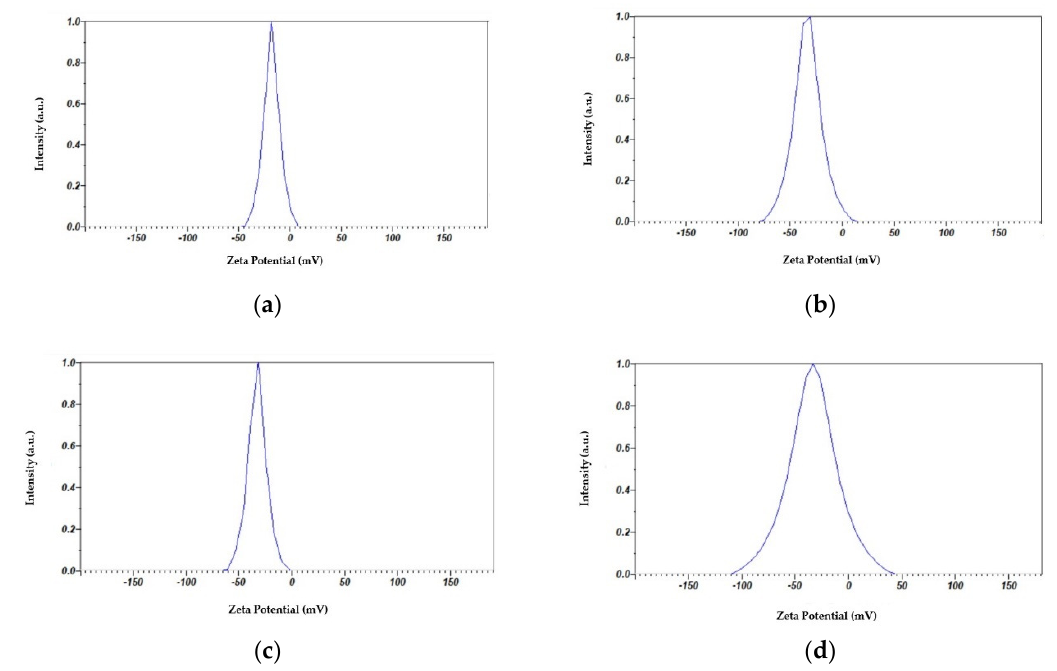
Figure 5. Zeta-Potential analysis of the four samples. From left to right: ( a ) TCA-AgNP; ( b ) TCA-AgNP-PI; ( c ) Cinn-AgNP; ( d ) Cinn-AgNP-PI.